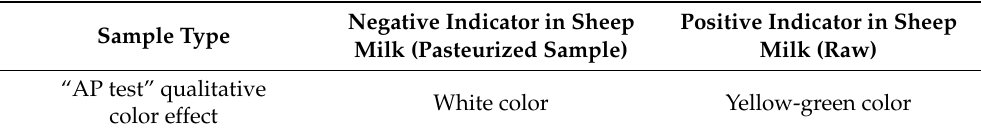
Table 2. Color interpretation of positive and negative control for “AP